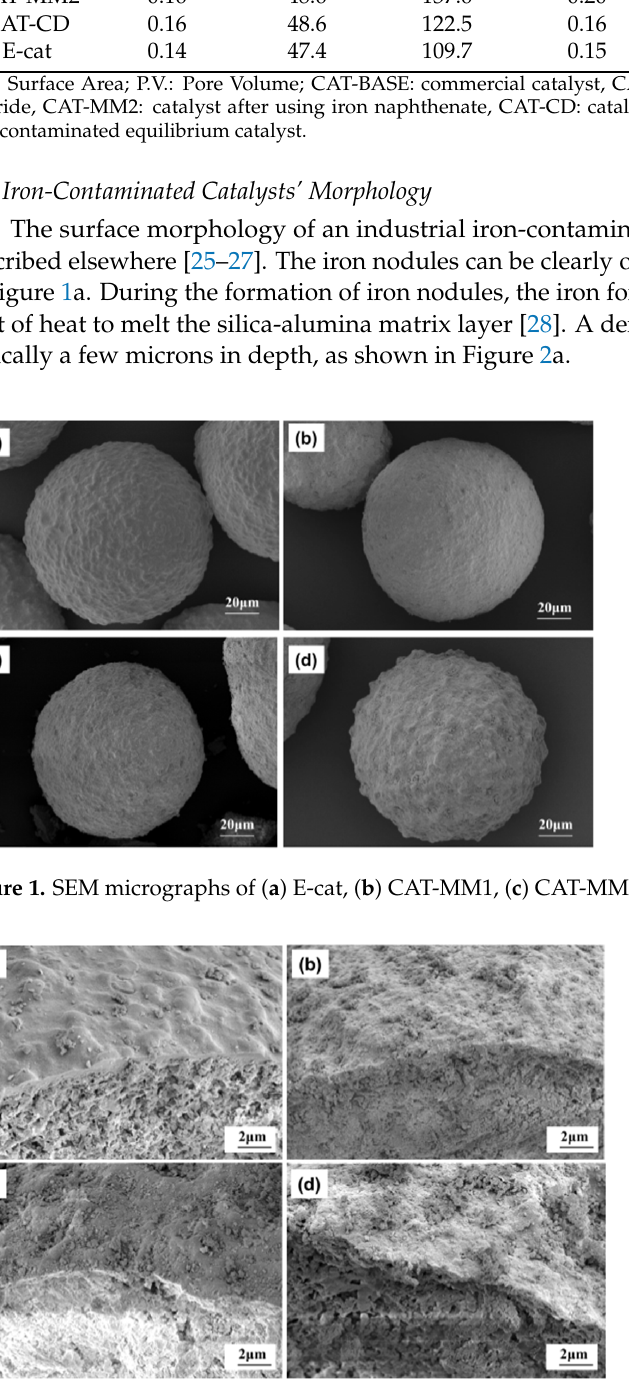
Figure 2. SEM micrographs of the catalyst cross-section: ( a ) E-cat, ( b ) CAT-MM1, ( c ) CAT-MM2, and ( d ) CAT-CD.